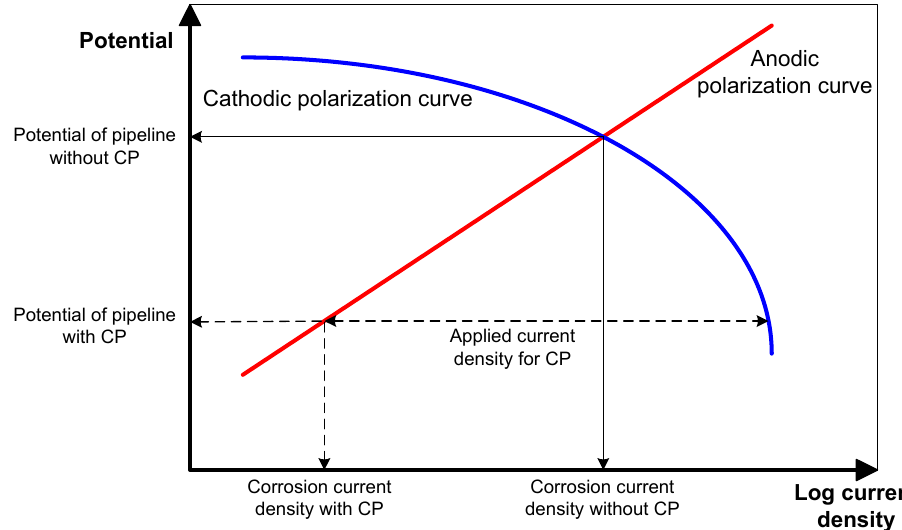
Figure 2. Evan's diagram, indicating the relationship between the applied current density and protection potential [16].